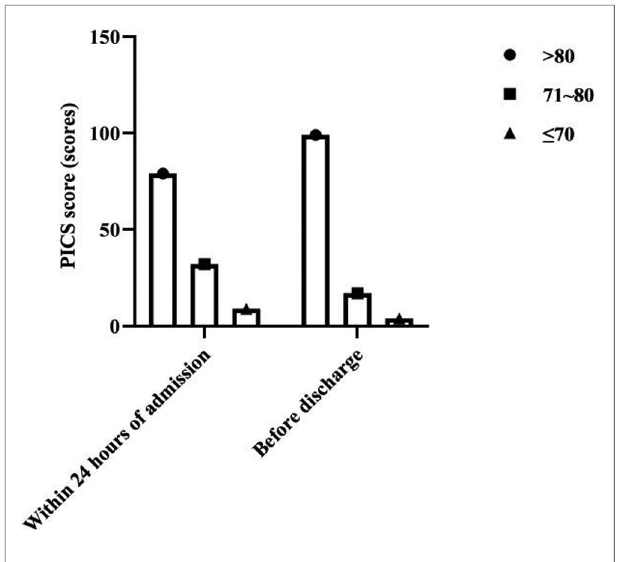
FIGURE 1 | PICS classi fi cation of 120 children with SMPP.